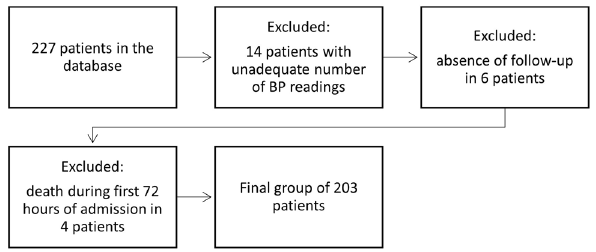
Figure 1. Flowchart showing categories of patients excluded from the